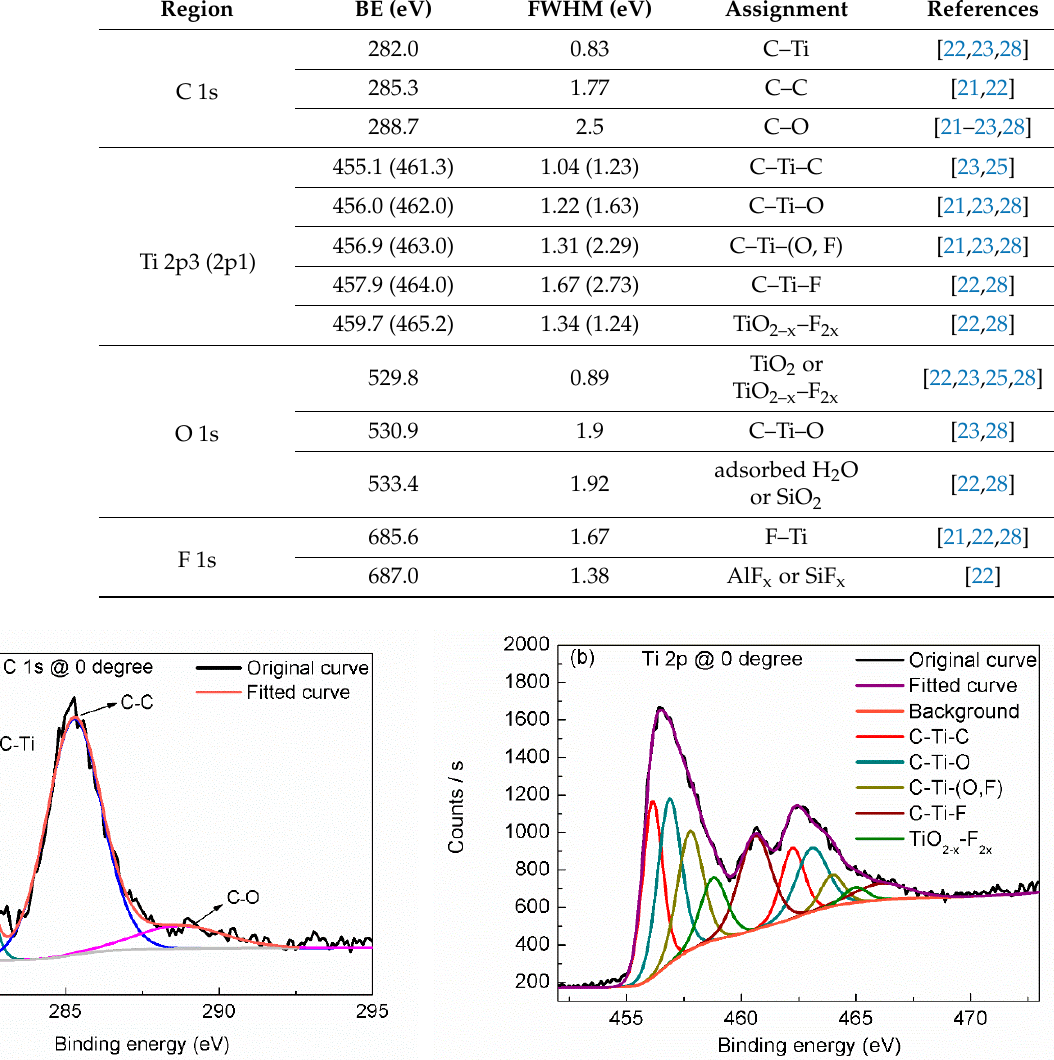
Figure 2. Peak fitting of narrow scanning, ( a ) C1s, ( b ) Ti 2p, ( c ) O 1s and ( d ) F 1s. Table 1. Peak-fitting results of C 1s, Ti 2p, O 1s and F 1s narrow scanning’s. Region